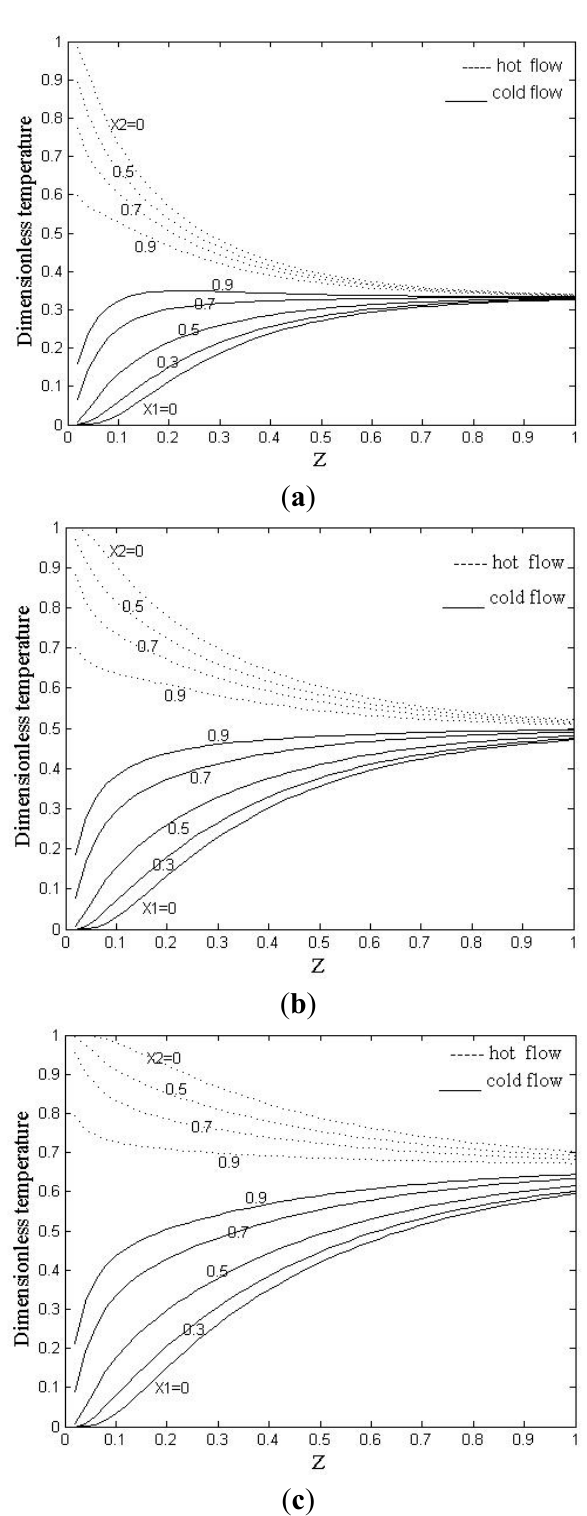
Figure 3. Temperature distribution for a parallel flow plate heat exchanger (Turbulent flow). ( a ) Two dimensional temperature distribution for K = 1, H = 0.5, K W = 0, and K t = 0.33; ( b ) Two dimensional temperature distribution for K = 1, H = 1, K W = 0 and K t = 0.33; ( c ) Two dimensional temperature distribution for K = 1, H = 2, K W = 0 and K t =